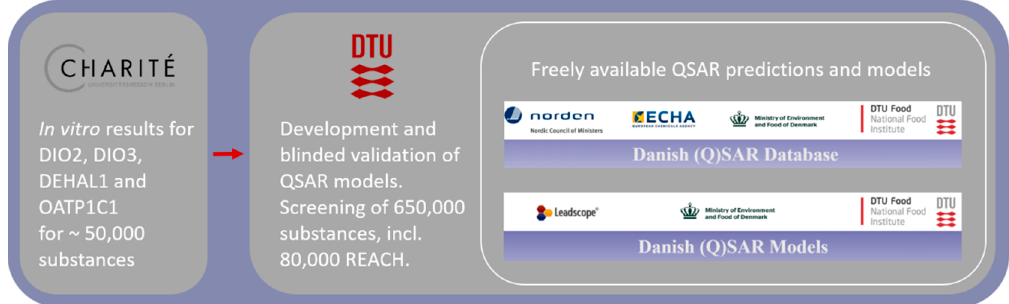
Figure 2. Relationship between quantitative structure–activity relationship (QSAR) development and results from high throughput assays in domain 2 of ATHENA.